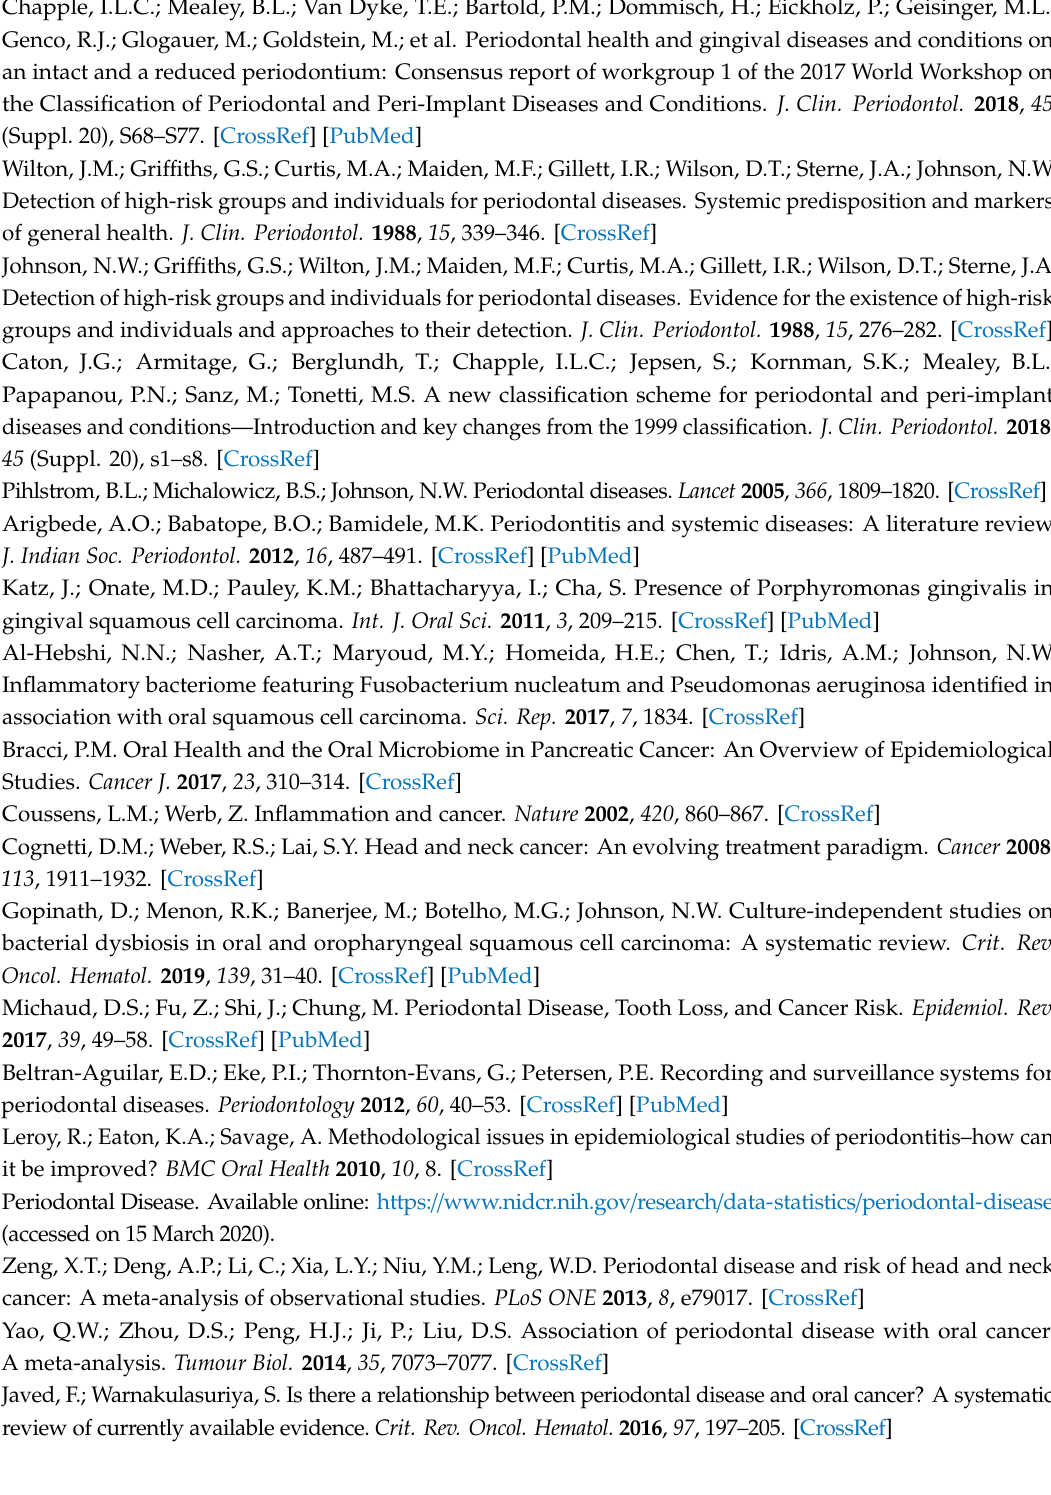
Figure S1: Funnel Plot. Table S1: Quality Assessment by Newcastle–Ottawa Scale for Case Control and Cohort studies. Figure S2: Egger’s